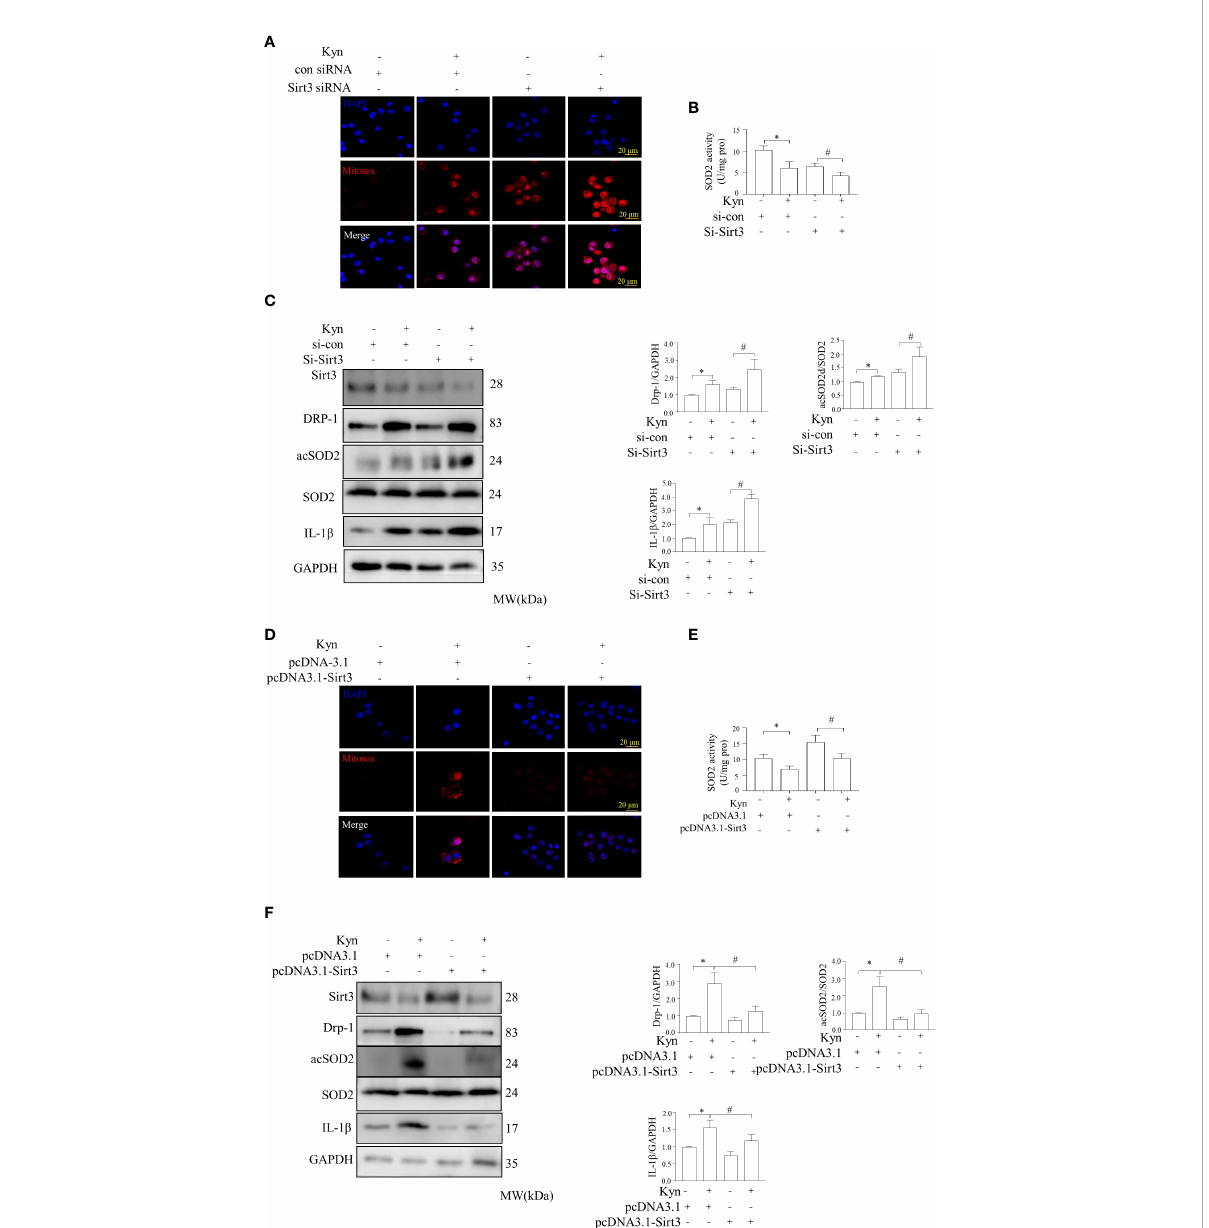
FIGURE 6 Downregulation and overexpression of Sirt3 altered the levels of in fl ammatory factors and oxidative stress levels in macrophages induced by Kyn. (A, B) Immuno fl uorescence staining showed that Sirt3 downregulation reduced the levels of mitochondria-derived ROS induced by Kyn. Mitochondria-derived ROS was detected using the MitoSox-probe and imaged using confocal microscopy. SOD activity was detected using the superoxide dismutase test kit. Macrophages transfected with sicon or siSirt3 were treated with Kyn. sicon was the negative control siRNA, while siSirt3 referred was the siRNA against Sirt3, scale bar, 10 m m, *:P < 0.05 vs.si-con; #P < 0.05 vs. Si-Sirt3, n=3. (C) Representative blots and quanti fi cation of acSOD2, Sirt3, IL-1 b , and DRP-1 expression following Kyn stimulation, transfected with negative control, *:P < 0.05 vs.si-con; #P < 0.05 vs. to Si-Sirt3, n=3. (D, E) Sirt3 upregulation decreased the levels of mitochondria-derived ROS induced by Kyn, as observed through immuno fl uorescence. Mitochondria-derived ROS and SOD activity was detected using MitoSox-probe and imaged using confocal microscopy.